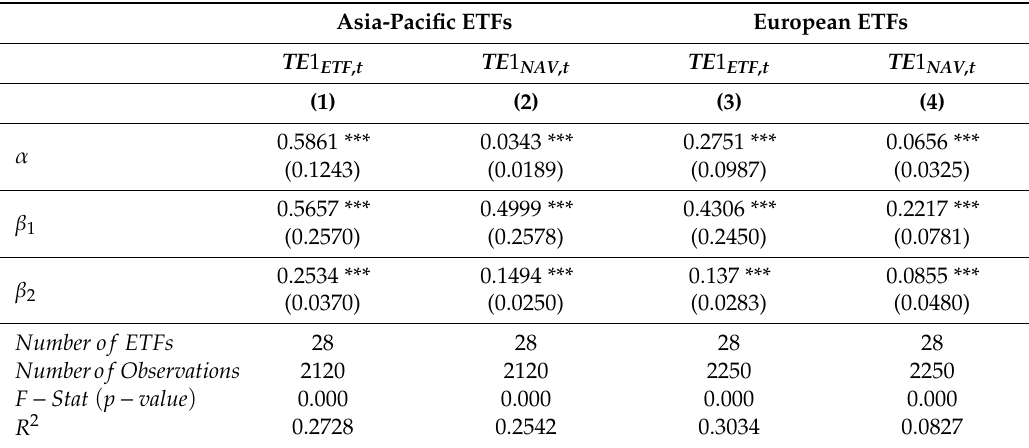
Table 5. Persistence of tracking errors in international